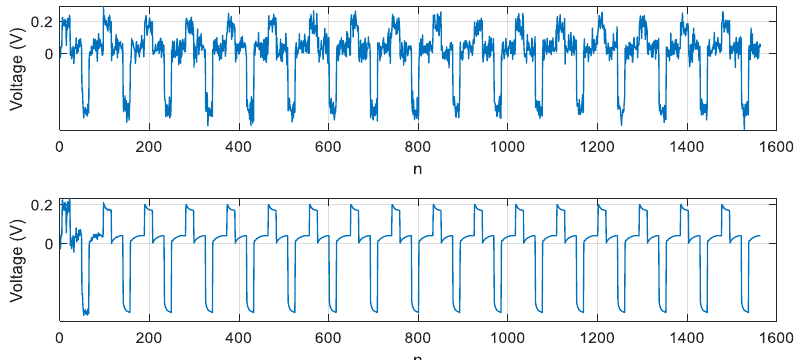
Figure 9. Dependence of the extracted signal on discrete time 𝑛 = 𝑡 Δ𝑡⁄ , Δ𝑡 = 1𝜇𝑠, implying an extraction obtained using the combined criterion based on skewness and kurtosis.